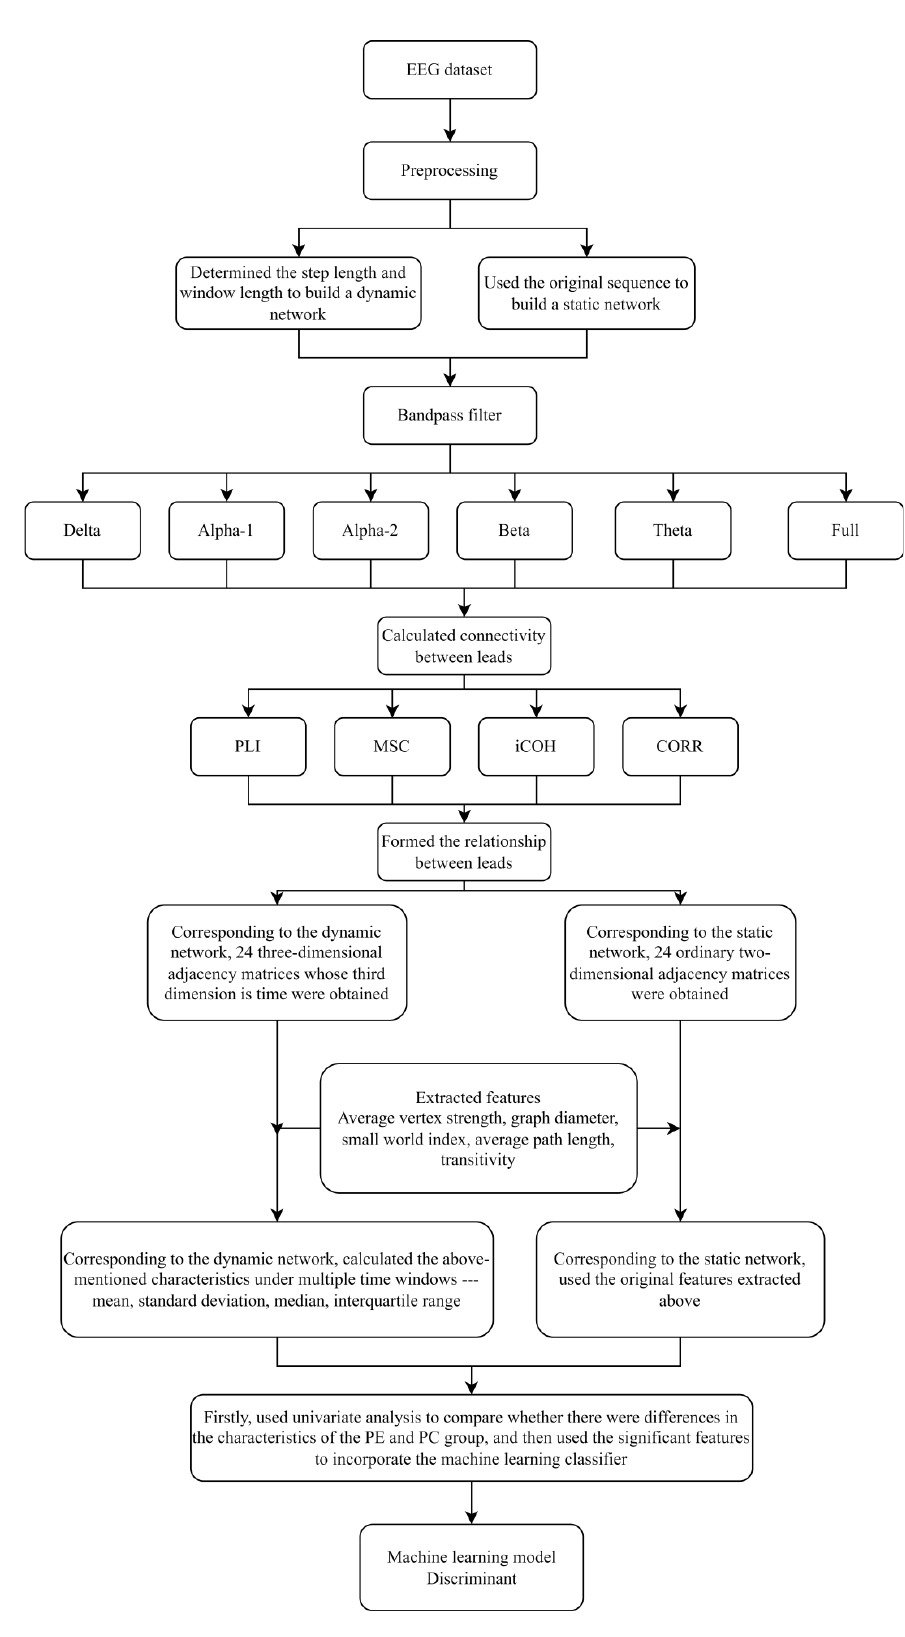
Figure 2. The roadmap of this